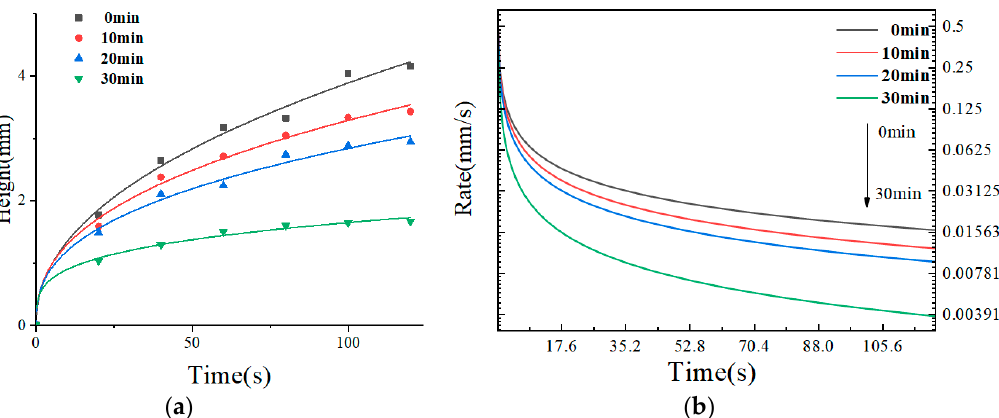
Figure 3. Relationship between the PDMS diffusion height, solidification time and diffusion rate. ( a ) Relationship between the PDMS height and the diffusion time; ( b ) relationship between the PDMS diffusion rate and solidification time after the calculation.